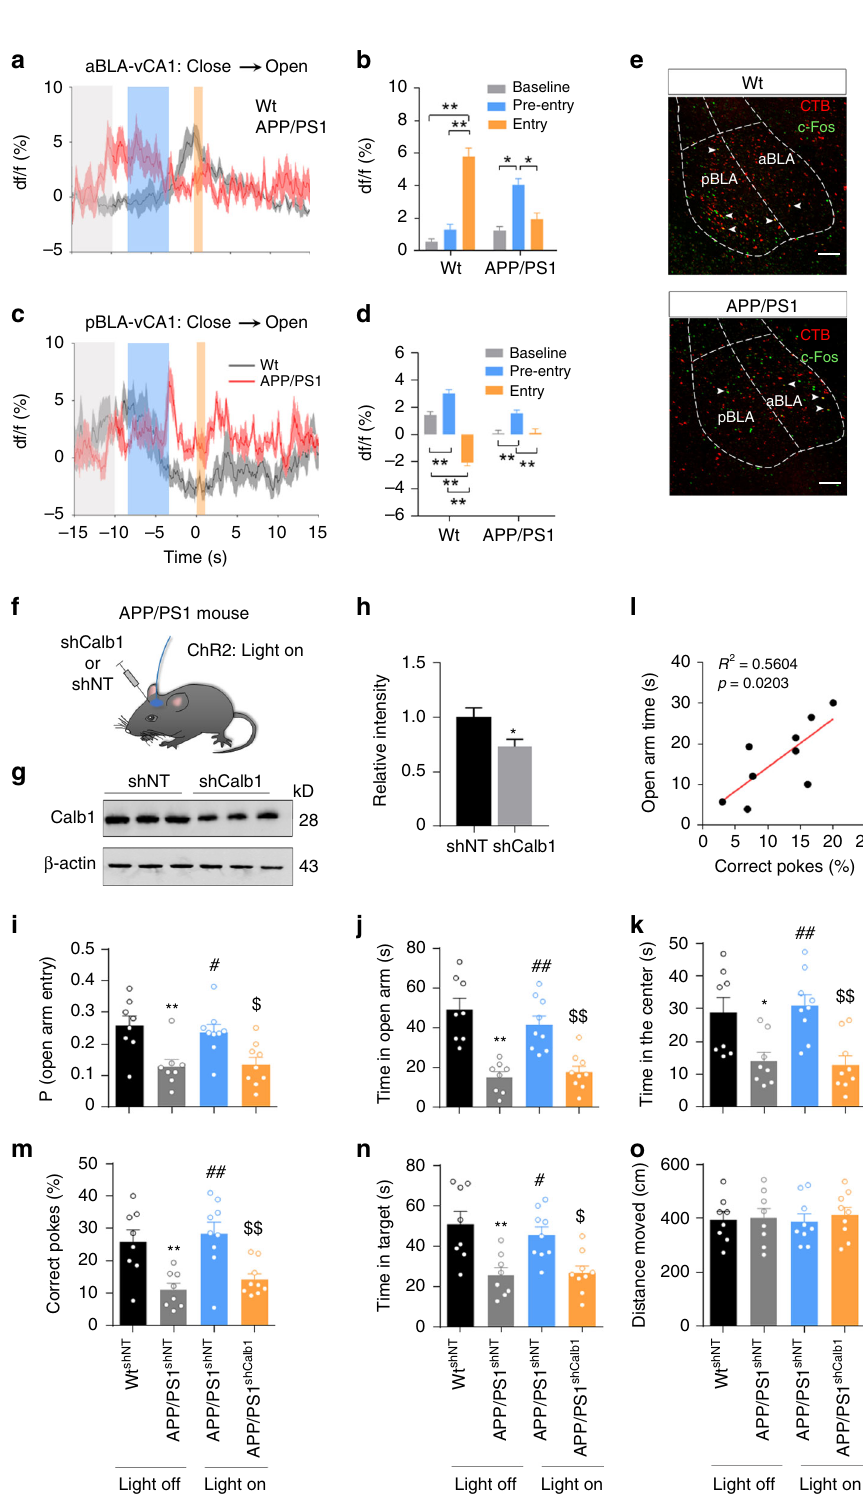
the anxiolytic effects of pBLA – vCA photostimulation in APP/PS1 mice as measured by the EPM (Fig. 6i, j) and OFT (Fig. 6k). These data, together, indicate that Calb1 is required for the anxiolytic effect of pBLA – vCA1 circuit stimulation in both wild-type and AD mice. Given that anxiety can exacerbate memory de fi cits in AD 20,26 , we administered the Barnes maze (BM) to test spatial cognitive functions in APP/PS1 mice. Improved performance during